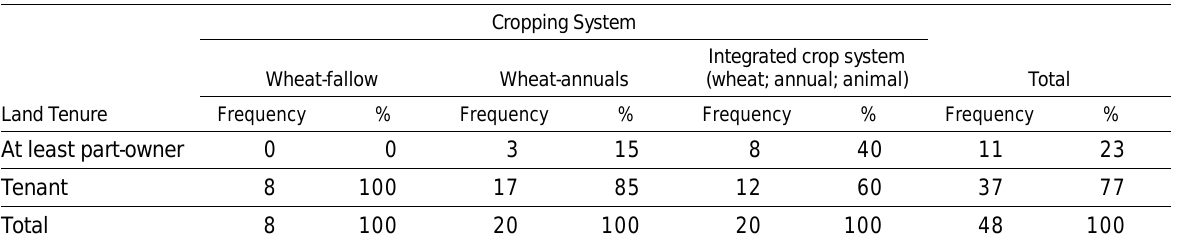
Table 3. Type of Marketing Channels Versus Land Tenure